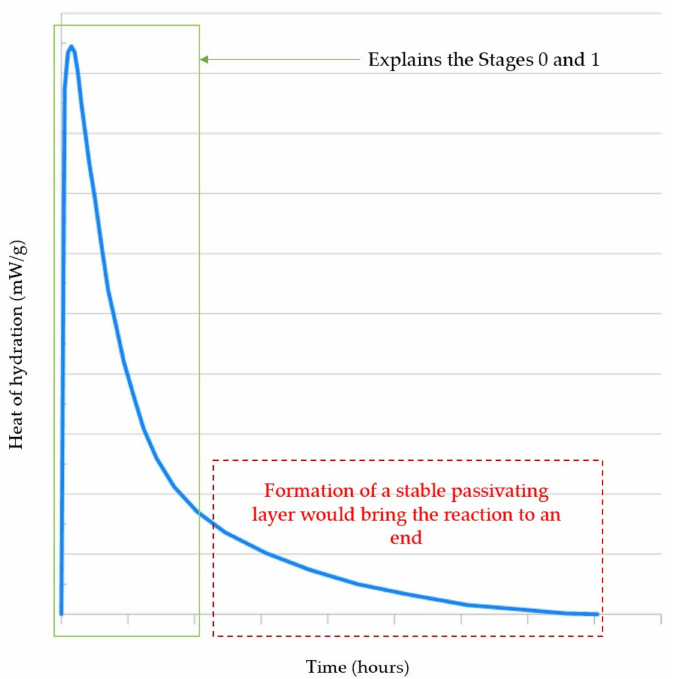
Figure 3. Expected rate of hydration by the protective barrier